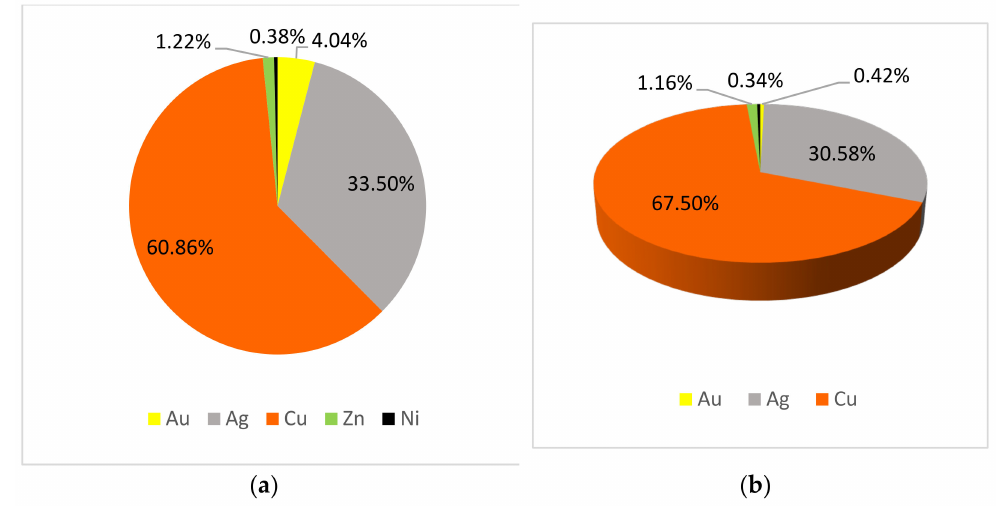
Figure 6. Metal content in folk costumes: ( a ) on the surface ( b ) in cross-section.